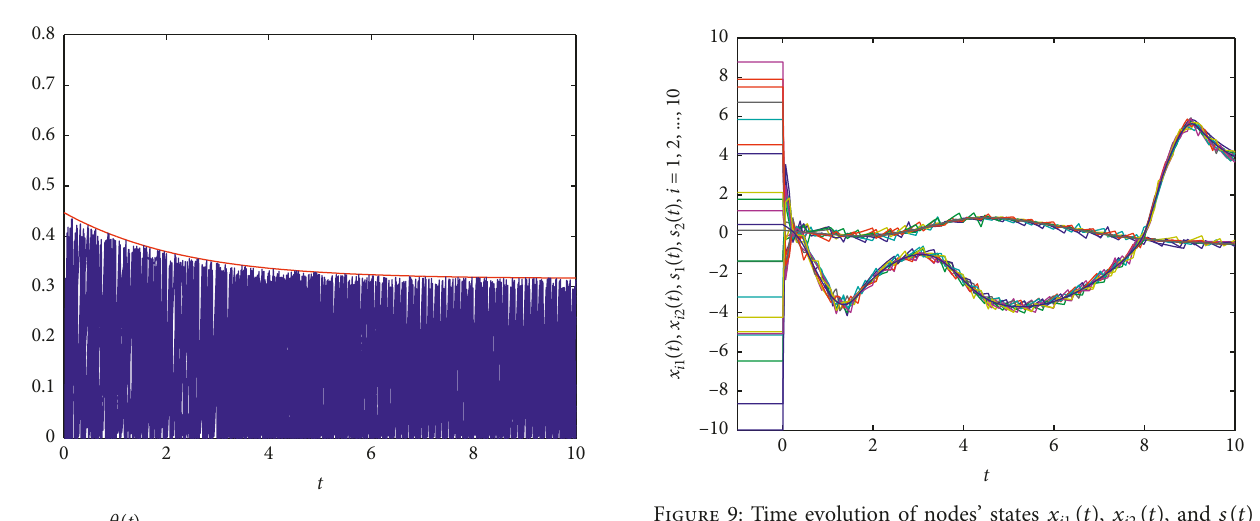
� 0 . 5 under continuous feedback, i � 1 , 2 , .. . , 10. 0